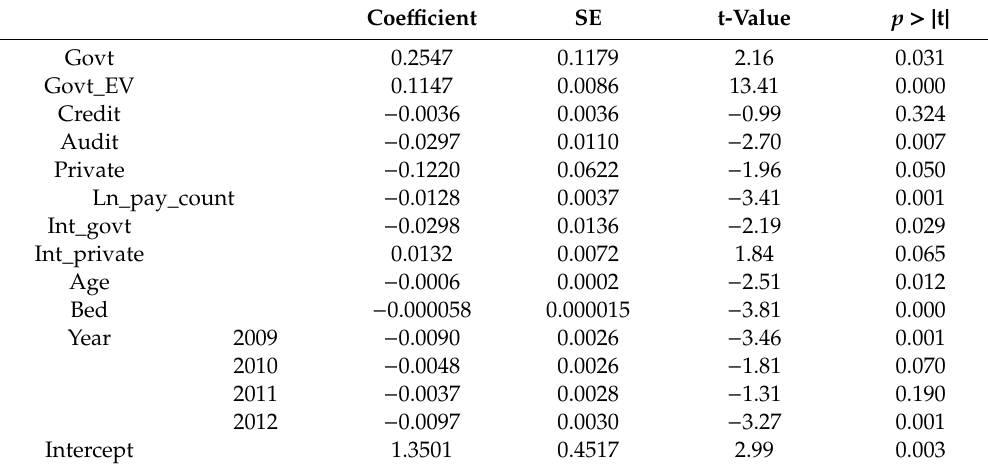
Table A6. Random e ff ects regression of publicness on social equity.